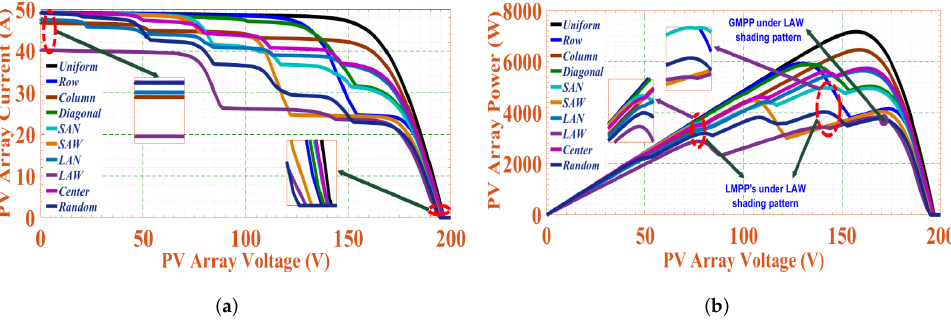
Figure 14. B-L-H-C topology results under various PSCs. ( a ) I-V characteristics, ( b ) P-V